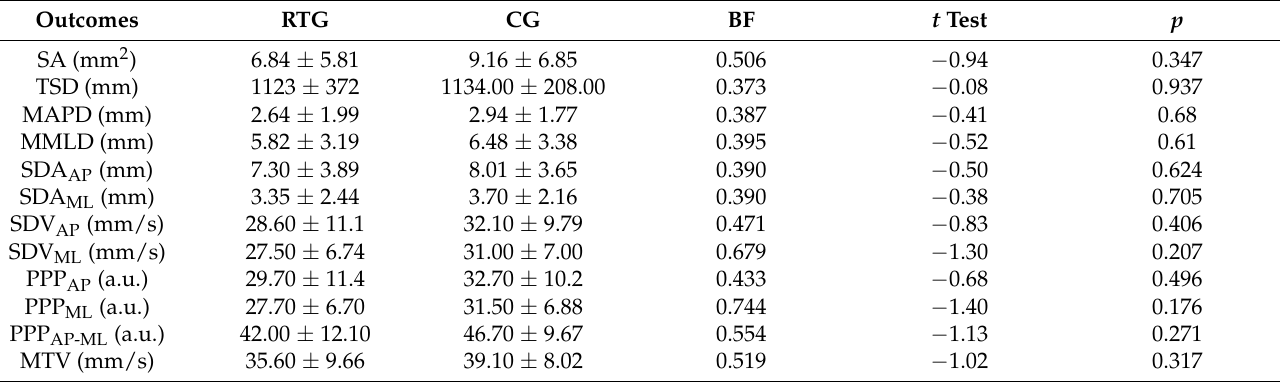
Table 5. Group comparisons in eyes-closed balance test after